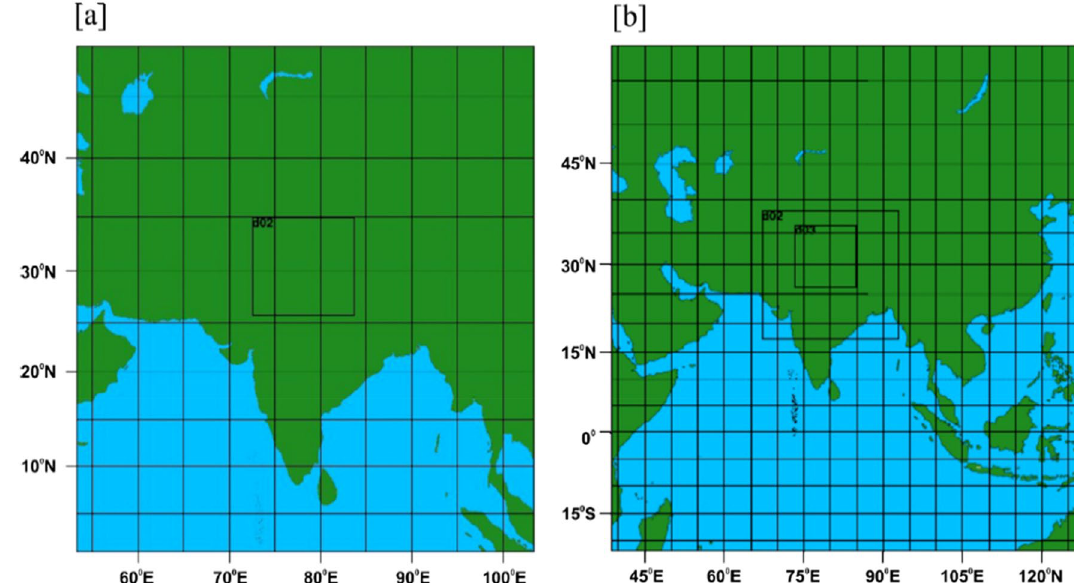
Figure 2. WRF domain setup. ( a ) 2009—two nested domains with horizontal resolution of 30 and 10 km; ( b ) 2014—three nested domains with horizontal resolution of 90 km, 30 and 10 km (Map created at IIRS—https:// www. iirs. gov. in/ inhou selab orato